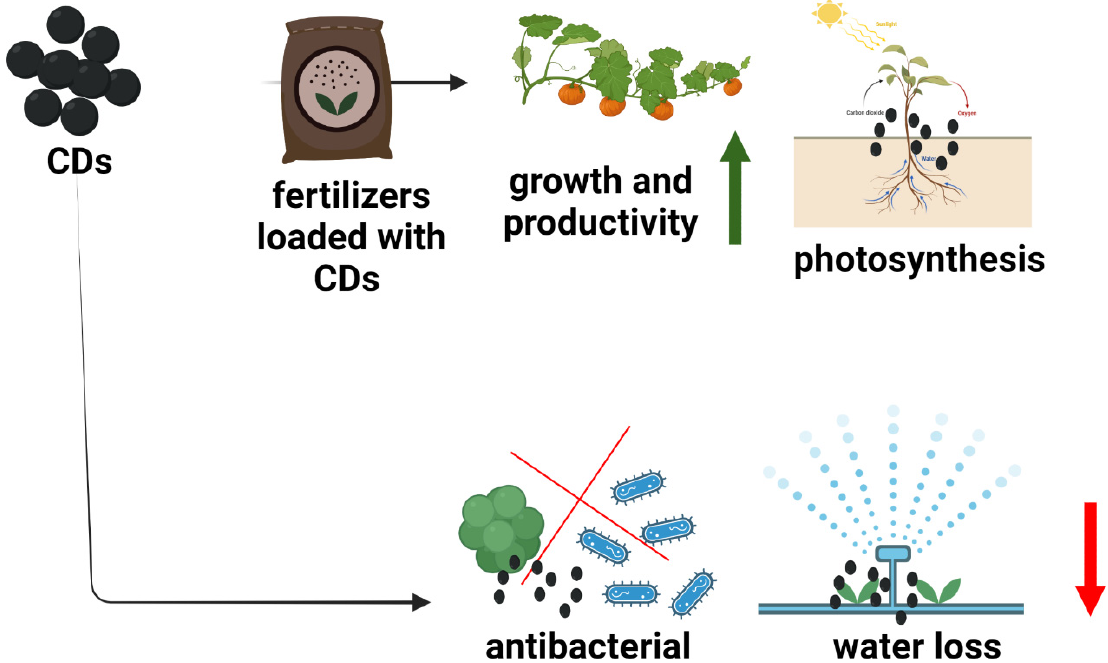
Figure 3. Application of carbon dots (CDs) on agricultural systems. CDs prevented water loss, agricultural produces storage, and enhanced photosynthesis. The Figure was created with BioRender.com (accessed on 1 September 2022).